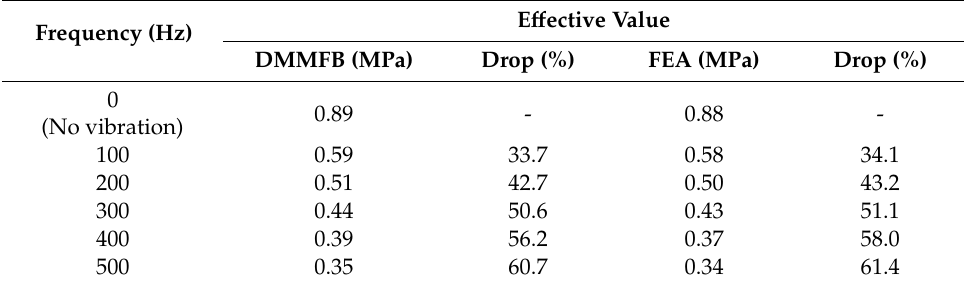
E ff ective value of the shear stress without and with 0.3 g vibration applied at di ff erent Table 7. Effective value of the shear stress without and with 0.3 g vibration applied at different frequencies.